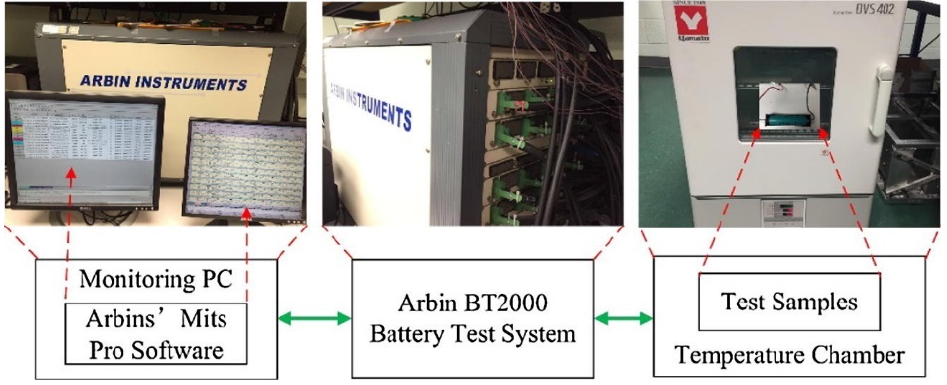
Figure 2. Test platform diagram.